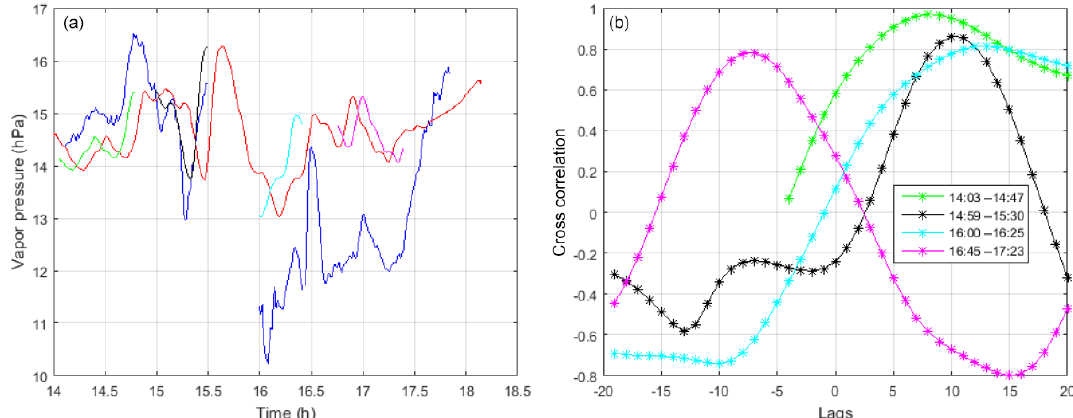
Figure 8. (a) Vapor pressure derived from ATOMMS observations (blue) and measured with an in situ sensor on Mt. Bigelow (red). Also shown in other colors are four time segments of the in situ observations shifted in time (as described in the text) to highlight the correlation between the two vapor pressure data sets. The time shift for each colored line is indicated in (b) . (b) Cross-correlation coefficients as a function of sample lags between the ATOMMS-derived vapor pressure and in situ measurements of water vapor taken on Mt. Bigelow. The four lines correspond with the four time segments described in the text: green (14:03–14.47), black (14:59 to 15:30), cyan (16:00 to 16:25) and magenta (16:45 to